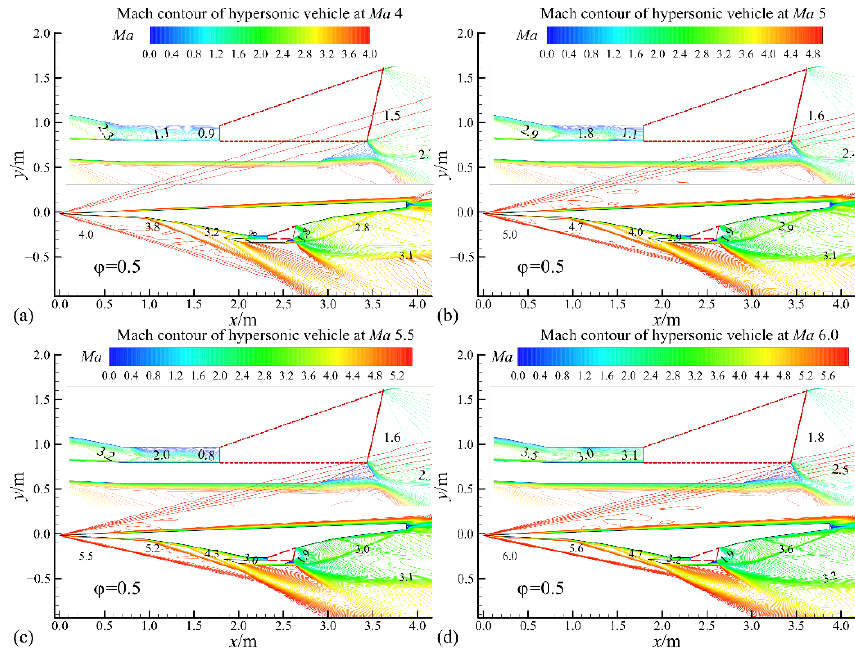
Figure 11. Mach contour of the hypersonic vehicle at off-design points from inflow Mach number 4 to 6. ( a ) Mach contour of the hypersonic vehicle at inflow Mach number 4.0; ( b ) Mach contour of the hypersonic vehicle at inflow Mach number 5.0; ( c ) Mach contour of the hypersonic vehicle at inflow Mach number 5.5; ( d ) Mach contour of hypersonic vehicle at inflow Mach number 6.0.